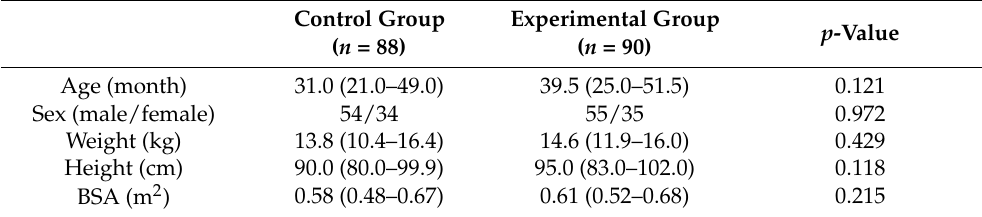
Figure 1. Consort flow diagram. Table 1. Demographic characteristics of children undergoing sedation for MRI scan.